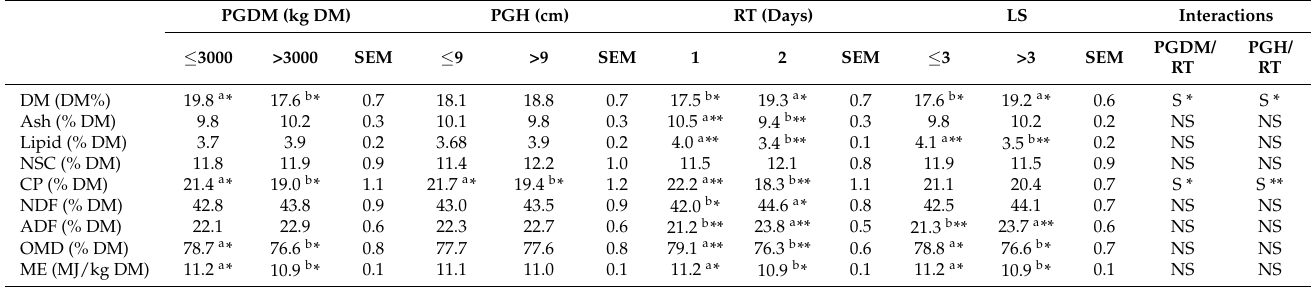
Table 7. The least square means of main effects upon the pasture herbage quality ( n = 112).